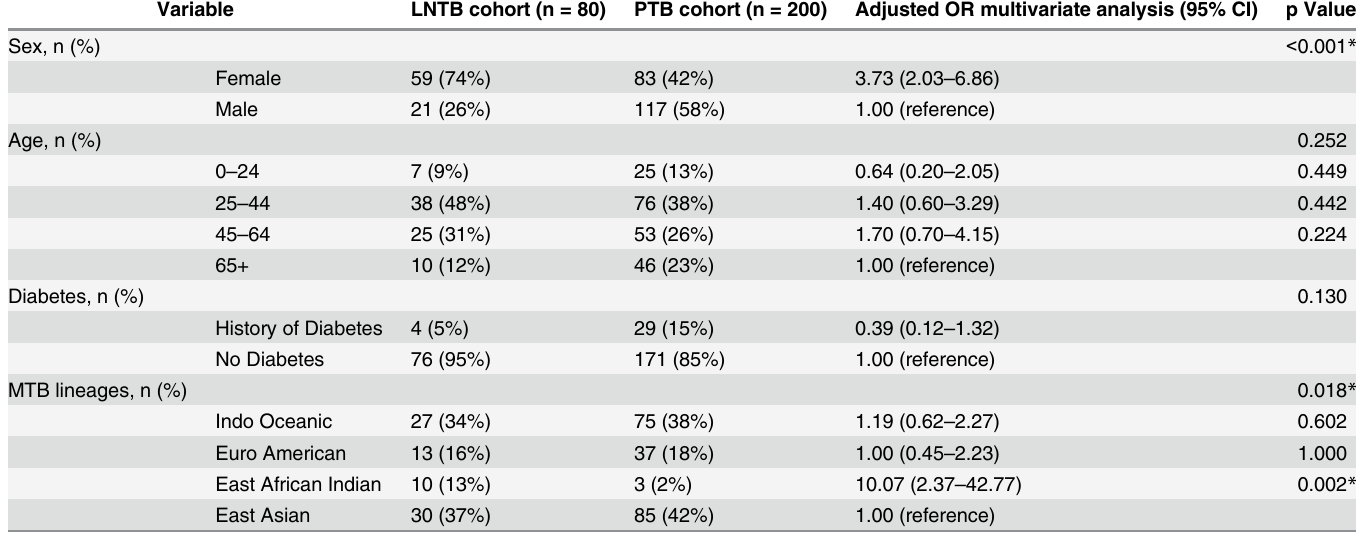
Table 3. Subset multivariate analysis including cases with MTB genotyping, associations with LNTB in multivariate analysis.